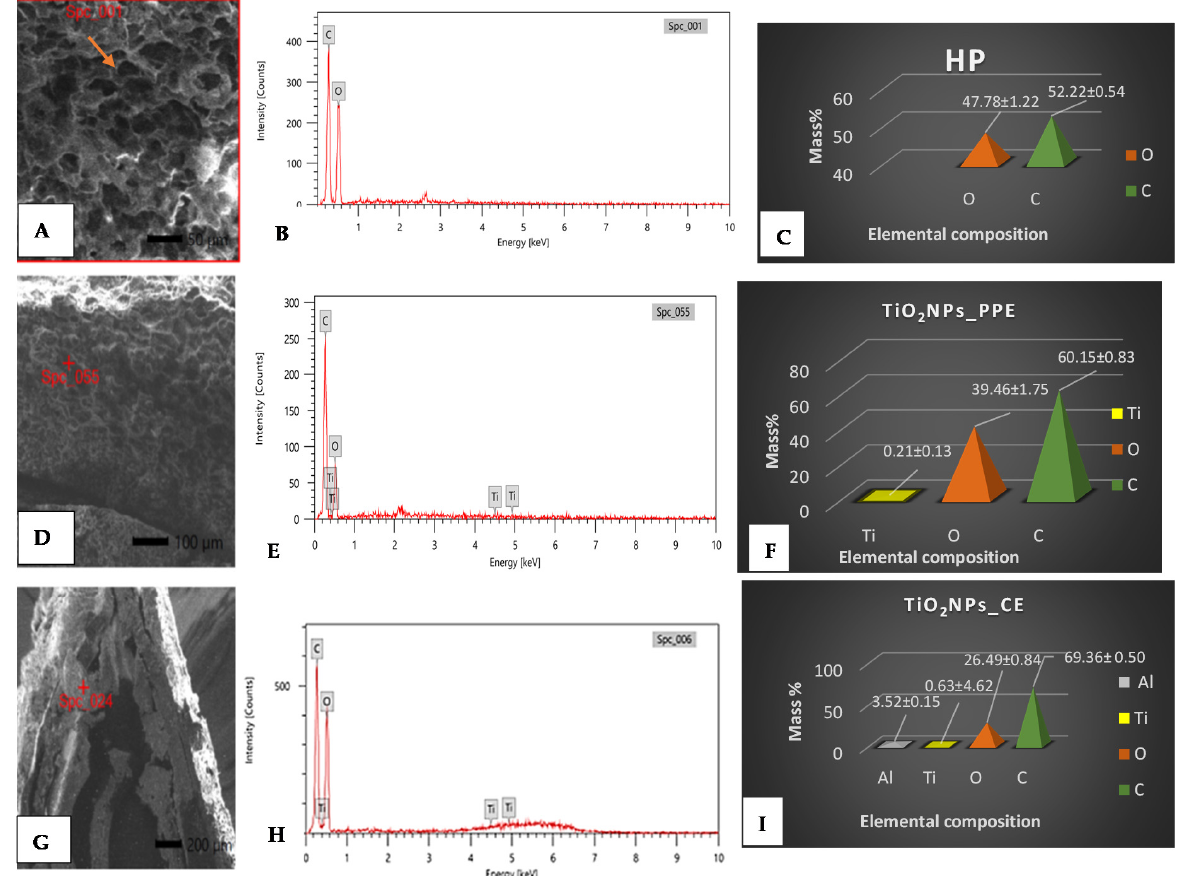
Figure 5. SEM–EDX-based analysis of hydroprimed seeds of P. granatum ( A – C ). Panels ( D – F ) show the adsorption of TiO 2 NPs_PPE and ( G , H ) show the adsorption of TiO 2 NPs_CE, and their detection by EDX on the surface of the seed coat. EDX spectra show element (C, O, and Ti) peaks and mass percentage of them. The SEM images represent the seed surface’s region of interest (ROI). The amount of the adsorbed C, O and Ti elements ( C , F , I ) is expressed as mean values of mass % obtained from sample replicates used for investigation, i.e., mean (%) ± SE.